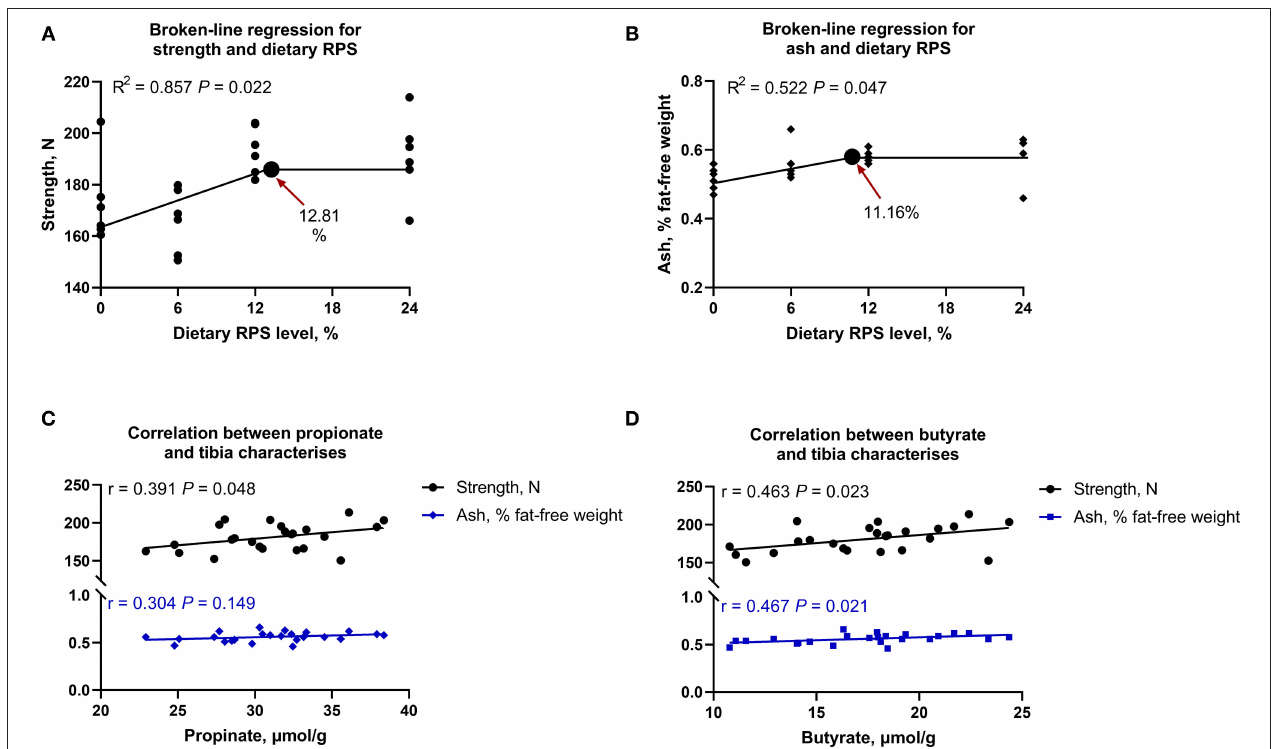
FIGURE 1 | The recommended level of dietary raw potato starch (RPS) based on broken-line analysis of (A) tibia strength and (B) ash content, as well as Pearson’s correlation (C) between tibia strength and ash and propionate level in cecal content, and (D) between tibia strength and ash and butyrate level in cecal chyme.